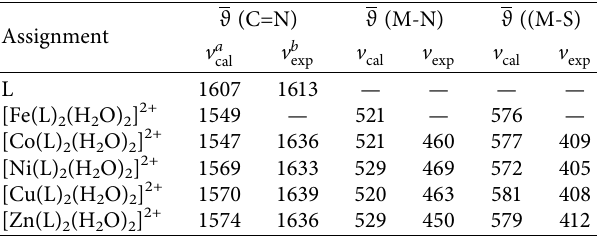
Table 2: Calculated (scaled) and experimental IR frequencies of ligand (MITMA) and its metal complexes at the BP86/def2-TZVP level of